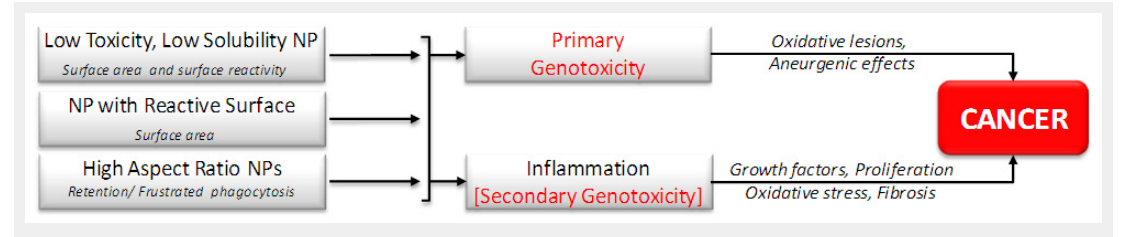
Diagram showing the potential processes that might be involved in NP carcinogenesis. Biologically effective doses are shown below each particle type on the left and potentially important pathobiological processes are shown around the arrows leading to cancer on the